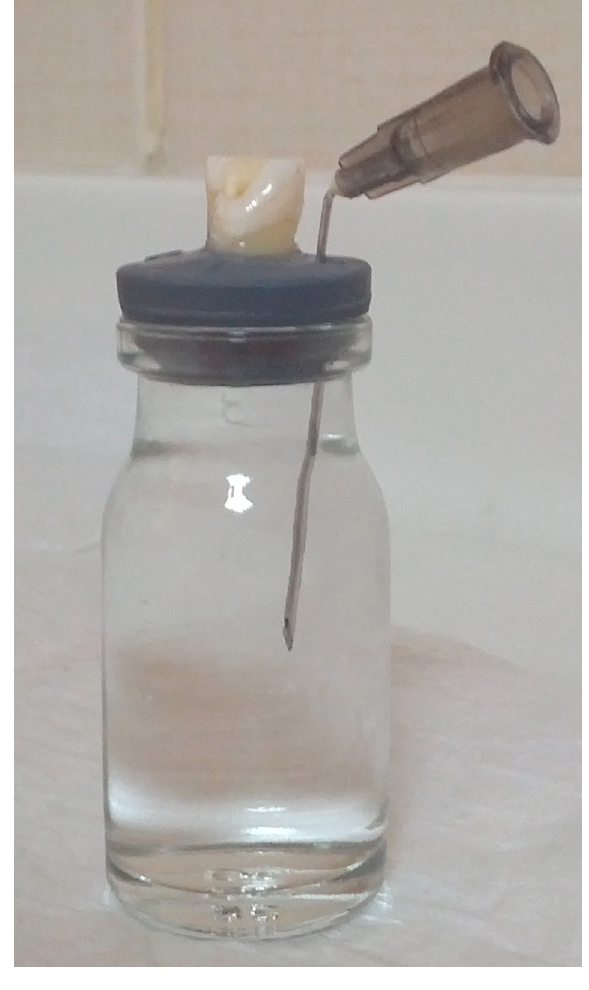
Figure 1. The amount of extruded irrigant